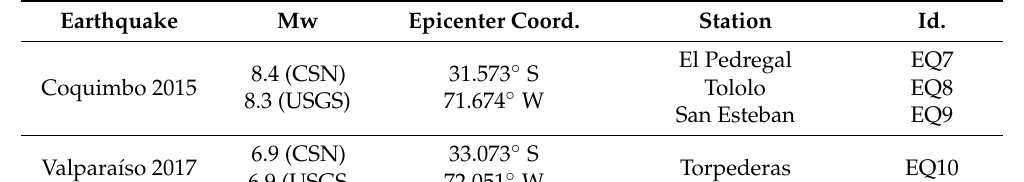
Figure 8. Chilean-code-based elastic (red) and reduced (blue) spectra relevant to Quillota (LAT − 32.881 LON − 71.244) for the ( a ) X and ( b ) Y components. Parameters used: soil factor S = 1.0; build- ing category I = 1.0 ; peak ground acceleration 𝑎 (cid:2868) = 3.924 m/s 2 ; damping ratio ξ = 5%; fundamental periods 𝑇 (cid:2869)(cid:3051) = 0.0904 s and 𝑇 (cid:2869)(cid:3052) = 0.1694 s ; reductions factors 𝑅 (cid:3025)∗ = 3.36 and 𝑅 (cid:3026)∗ = 4.73 .